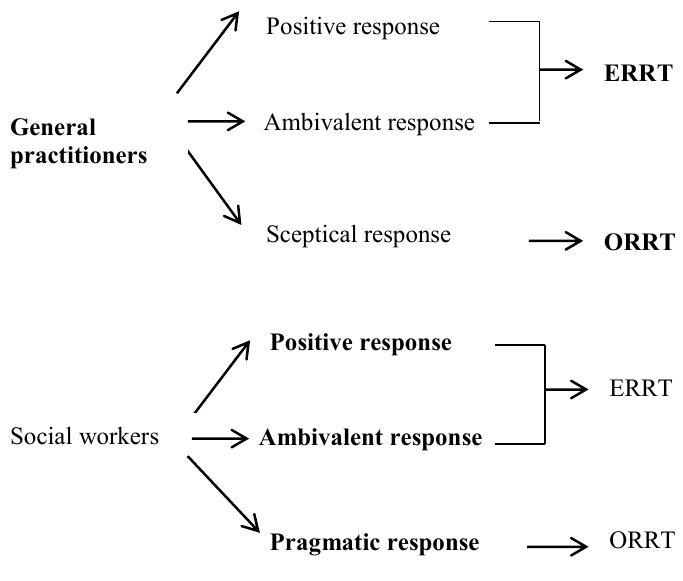
Figure 1. General practitioners and social workers’ response to ERRT and